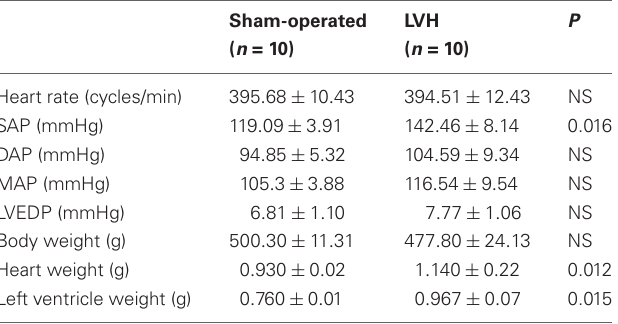
Table 1 | Clinical and anatomical characteristics in sham-operated and LV hypertrophy groups.